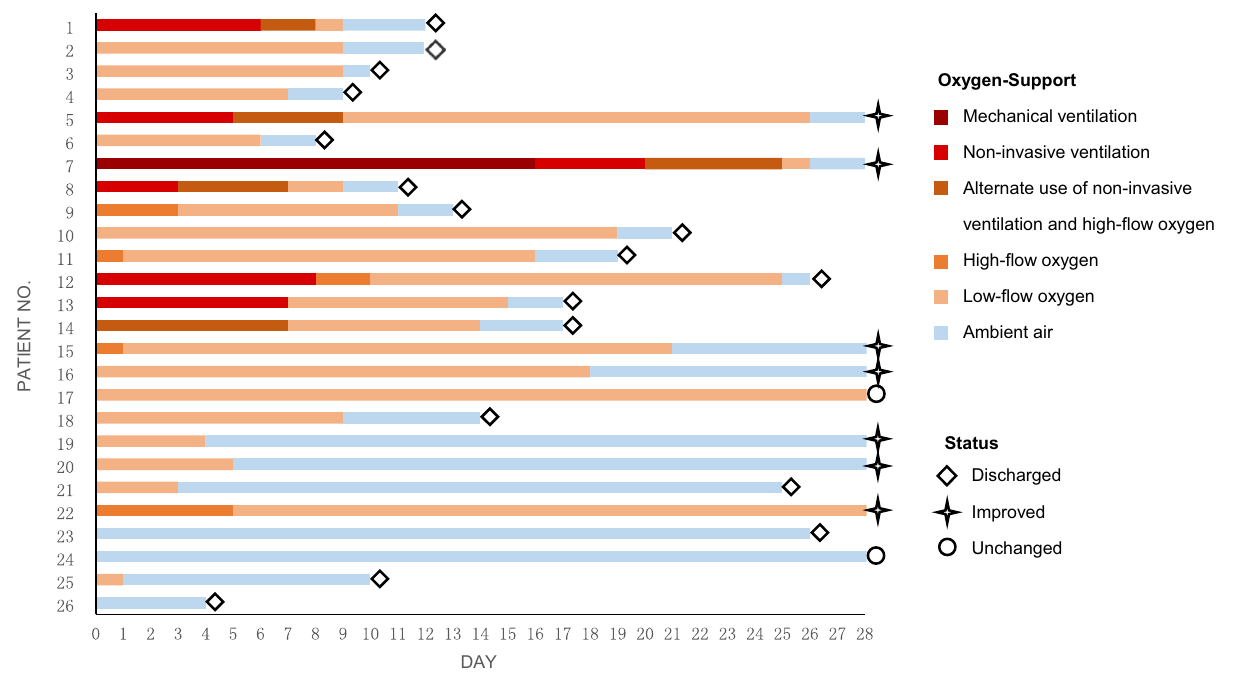
Fig. 3 Changes in oxygen-support status in individual patients. Baseline (day 0) is the day when treatment with a single dose of bevacizumab was performed. The fi nal oxygen-support statuses are on the discharge date or at the end of the 28-day follow-up. For each individual patient, colored columns represent the oxygen-support status of the patient over time. Diamond symbols represent patients discharged from hospitals; star symbols represent patients improved but not discharged, and circle symbols show patients